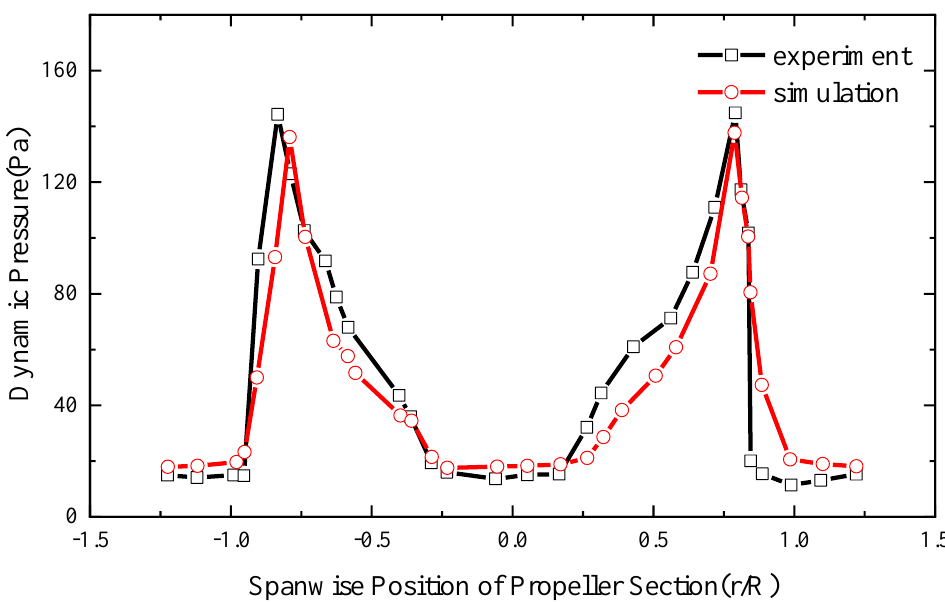
Figure 6. Z-velocity distribution in the section of y = 0.175 span.